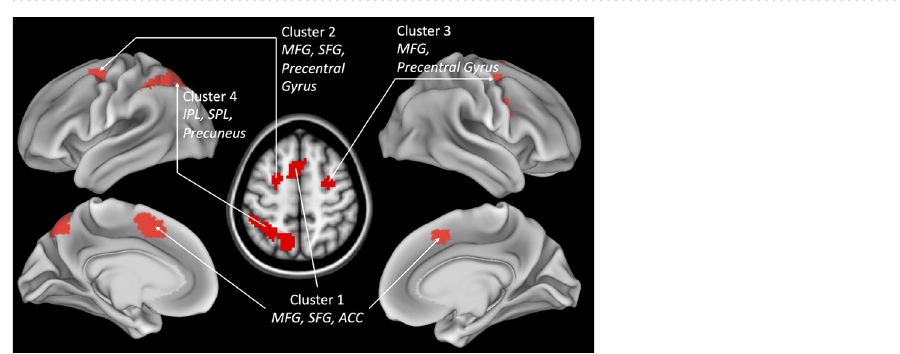
Figure 2. Common activation of the four tasks assessing the executive functions (EF) updating, switching, inhibition, and dual-tasking. To examine common activations across four executive tasks, a conjunction analysis performed with four contrasts UPD-CT3, INH-CT3, SW-average of CT1 and CT2, DT-CT1-CT2 using logical AND approach. Map thresholded at voxel-level p < 0.005 (uncorrected) and cluster-level p < 0.05 (FWE corrected). MFG Middle frontal gyrus, SFG Superior frontal gyrus, ACC Anterior cingulate cortex, SPL Superior frontal gyrus, IPL Inferior frontal